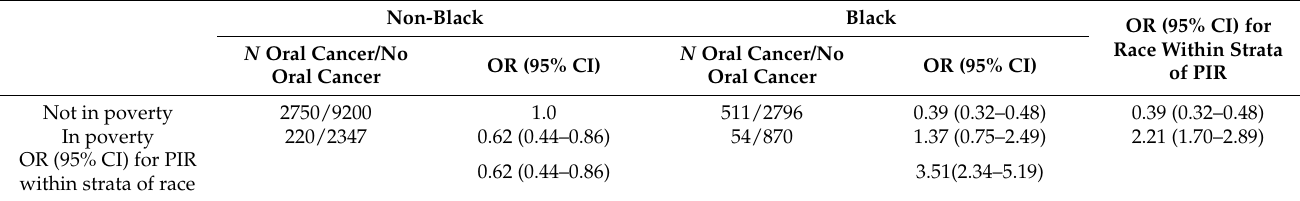
Table 3. Confounded interaction analysis between poverty status and race on the risk of having an oral cancer check, N =